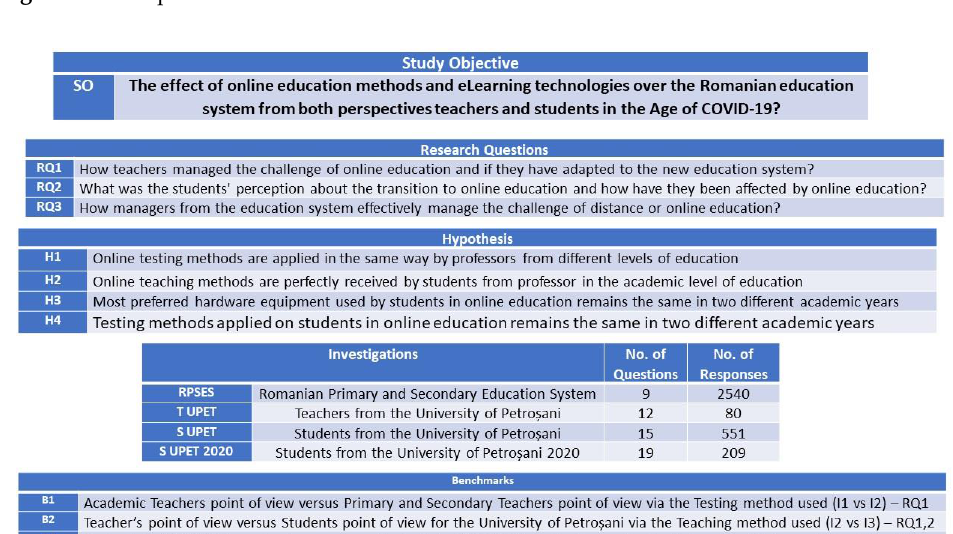
Figure 2. Detailed conceptual research model.